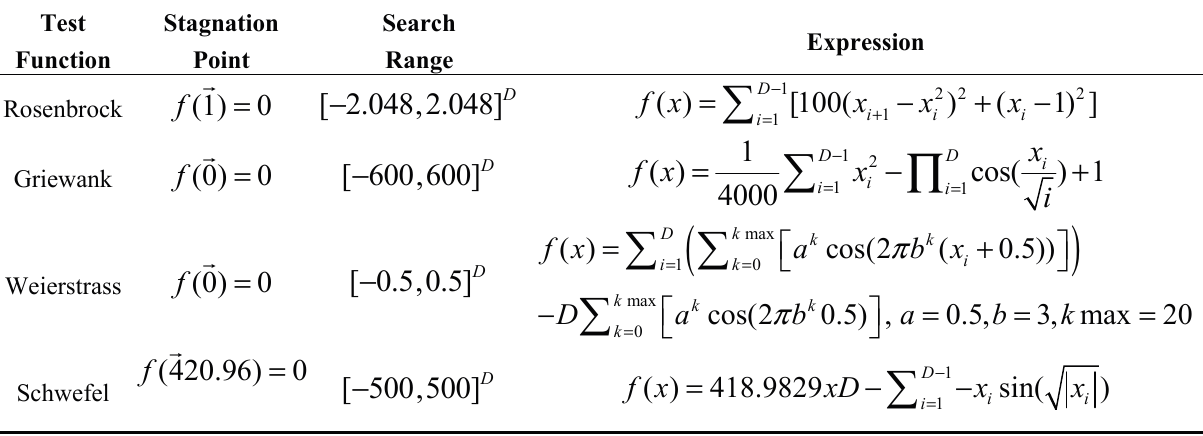
Table 3. Basic test functions employed in the simulation experiment.